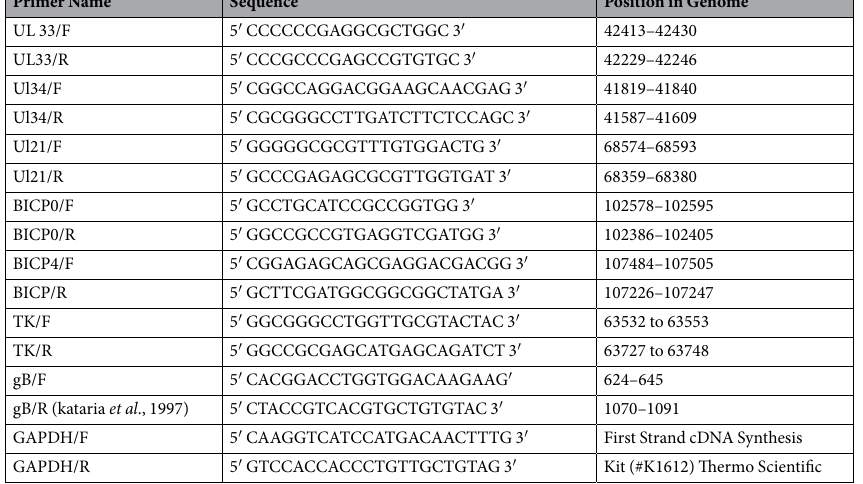
Table 1. Oligonucleotide PCR